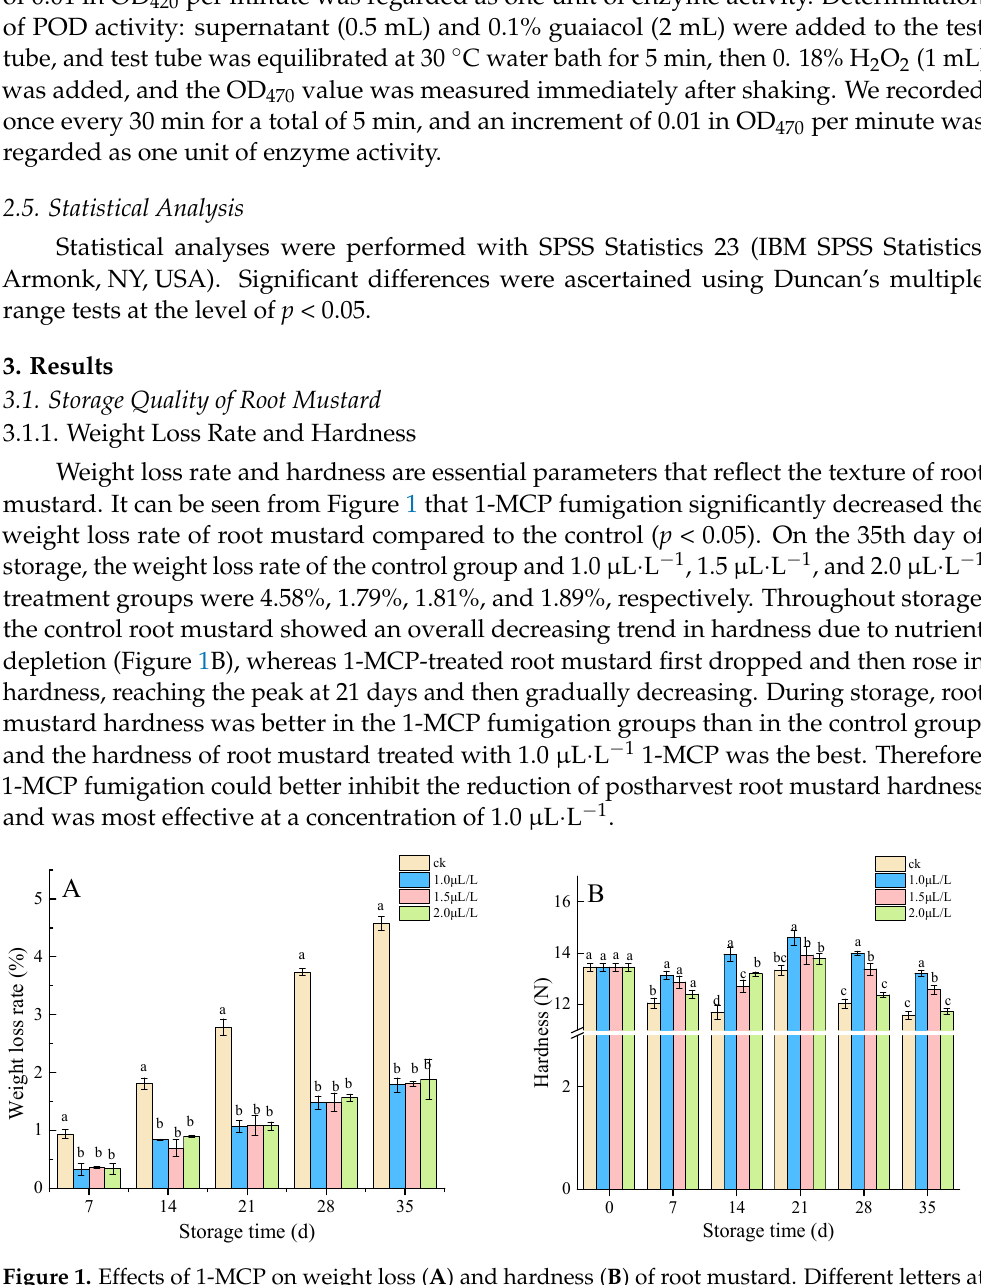
Figure 1. Effects of 1-MCP on weight loss ( A ) and hardness ( B ) of root mustard. Different letters at each time point indicated a significant difference between treatments ( p < 0.05) by Duncan’s multiple range test.